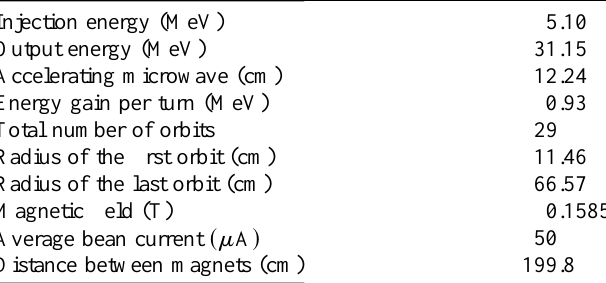
TABLE I. Parameters of the main racetrack